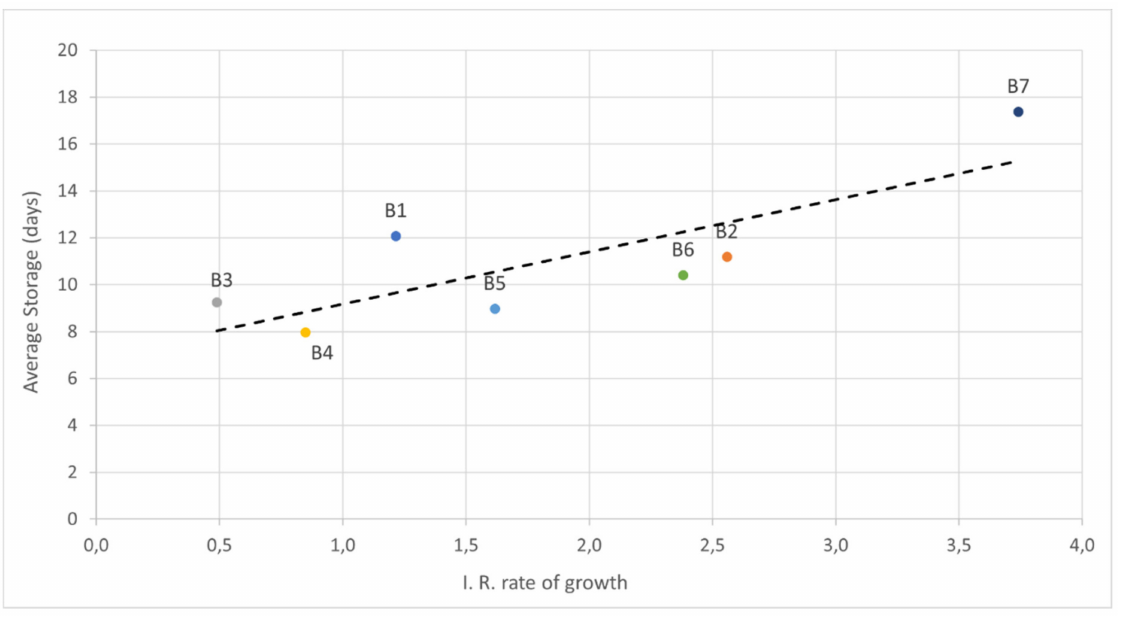
Figure 16. Average storage time vs. internal resistance